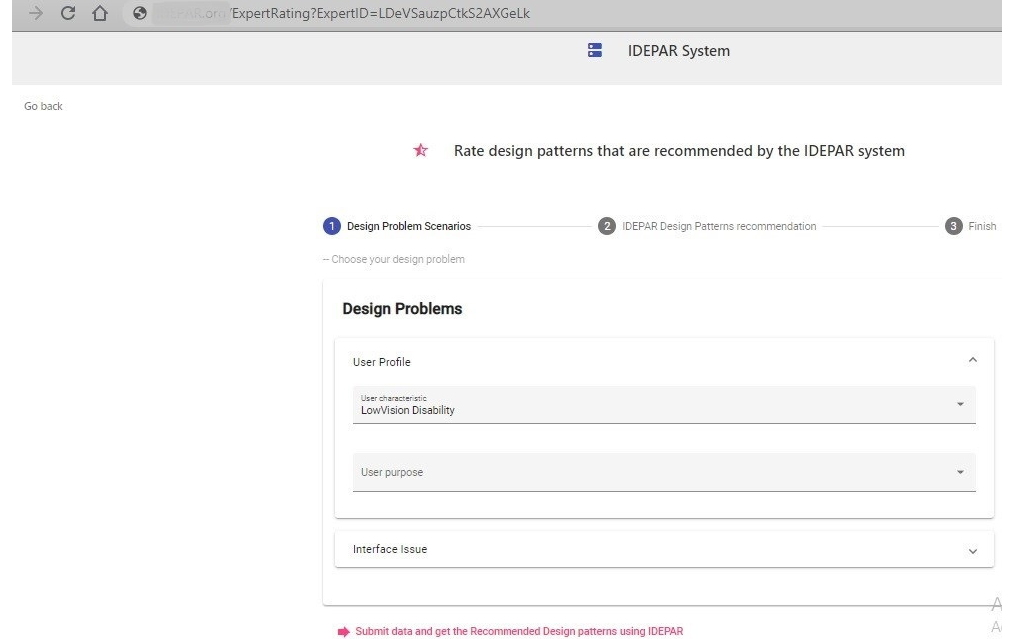
Figure 16. Selection of design problem DPS-2.